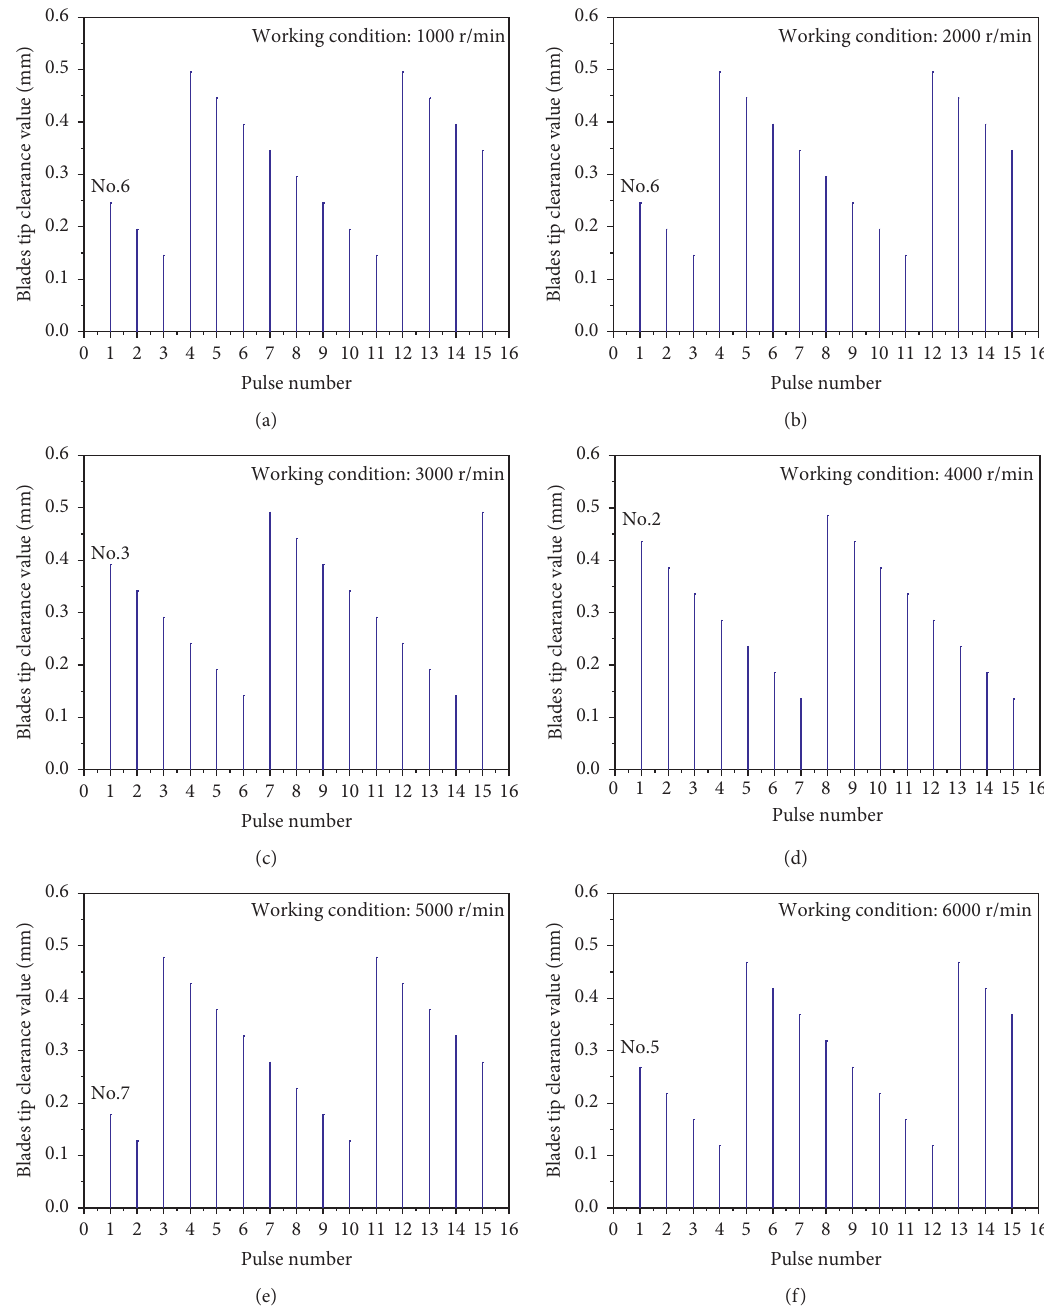
Figure 3: Dynamic blade tip clearance pulse sequence under different working conditions. (a) 1000r/min. (b) 2000r/min. (c) 3000r/min. (d) 4000r/min. (e) 5000r/min. (f) data is measured by the OPR sensor, which provides a time the servo motor driver, turn on the blade tip-timing sensors, reference for the verification of the blade serial number data acquisition, and processing system. Manually rotate the identification method. When the rotating speed is stable at blades in the order of number to directly below the first blade 2000 r/min, two sets of blade tip dynamic clearance se- tip-timing sensor; measure the voltage value corresponding quences are measured by the blade tip-timing sensors TIP1 to the tip clearance of each blade under static state, and the ] in equation (1) is obtained as shown in Table 3. and TIP2. Use equations (3) and (4) to modify the sequences, sequence [ δ 1 and extend the modified sequences by one cycle. The Turn on the servo motor drive, and according to the modified and extended two groups of blade tip dynamic Campbell diagram, the rotating speed is increased to 2000 r/ clearance sequences are shown in Figure 6. min of nonresonant rotating speed, and the rotating speed